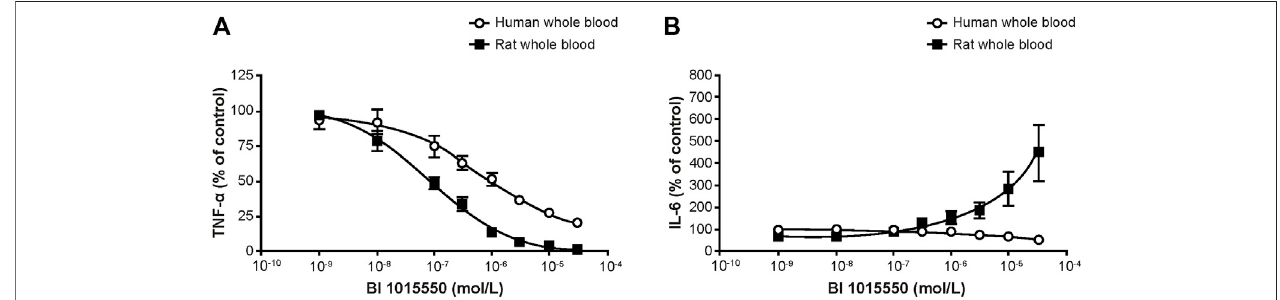
FIGURE 2 | Effect of BI 1015550 on LPS-stimulated TNF- α (A) and IL-6 (B) release in human and rat whole blood. Results are given as means ± SEM from 4 independent experiments. Whole blood from WI (Han) male rats and from healthy male human donors was treated with 1 µL (rat) or 2.5 µL (human) of BI 1015550 or vehicle (DMSO 0.5% v/v). After incubation, cultures were treated with LPS at a fi nal concentration of 10 µg/mL (rat), 0.1 µg/mL (human), or saline. DMSO, dimethyl sulfoxide; IL-6, interleukin-6; LPS, lipopolysaccharide; SEM, standard error of the mean; TNF- α , tumor necrosis factor- α ; WI, Wistar.